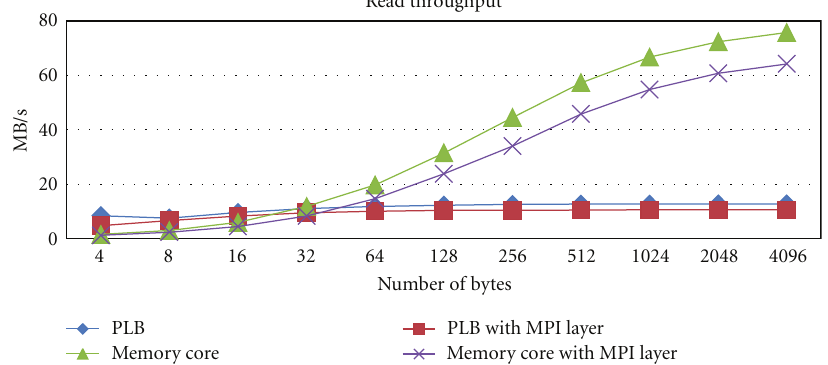
Figure 13: Comparison of the achievable read throughput in MB/s at 125 Mhz: Star-Wheels NoC and adaptive memory core versus PLB and Xilinx MPMC controller, both with and without MPI